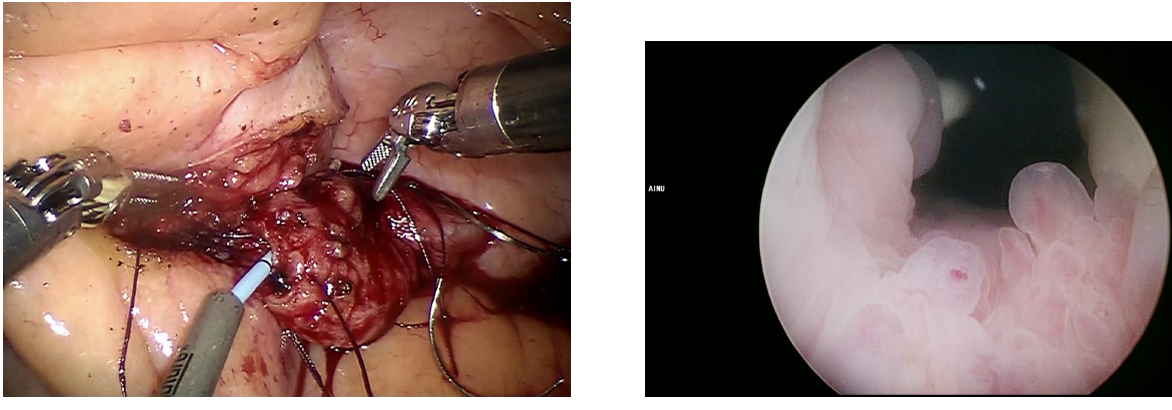
Figure 8. Cystoscopy- features of cystitis